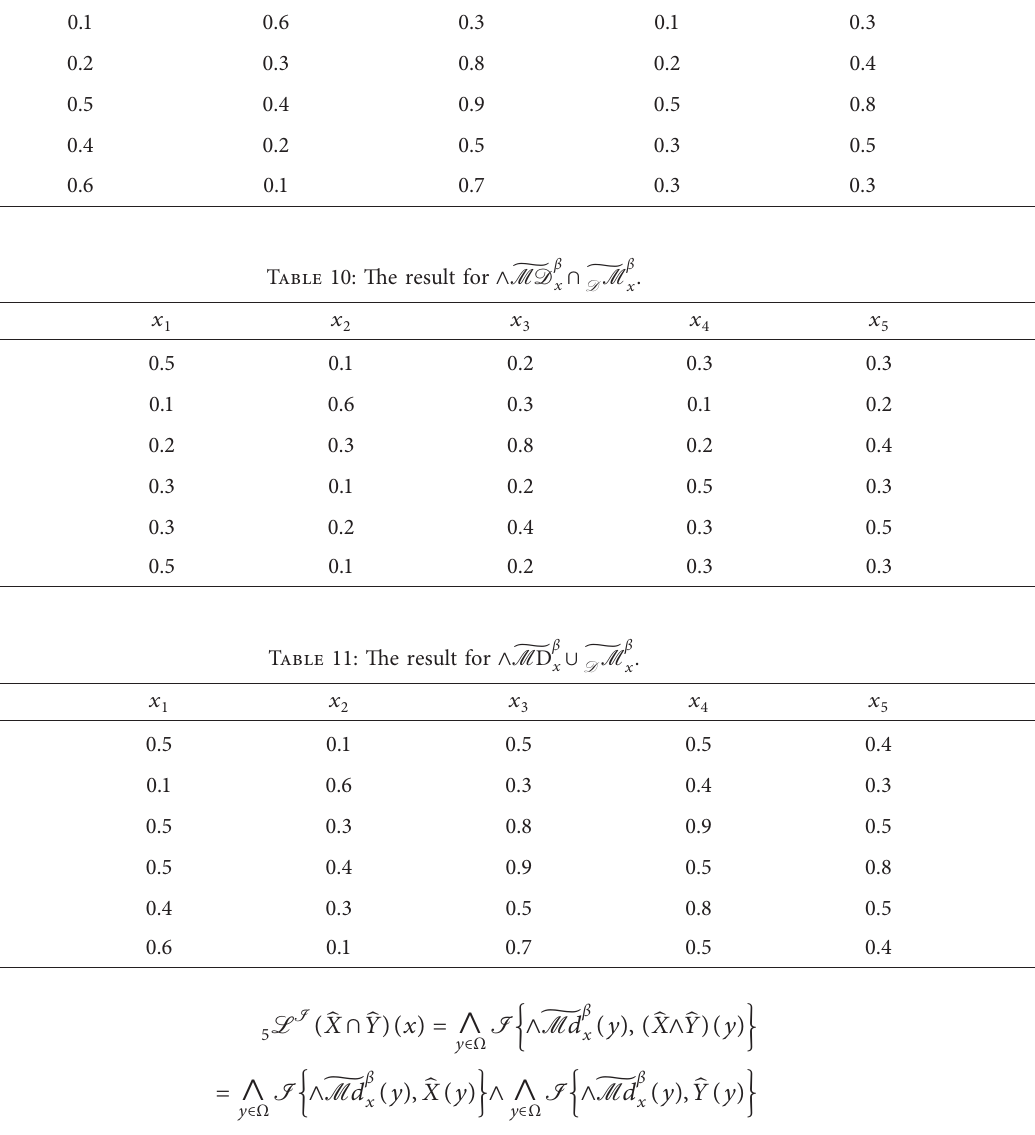
Table 9: Values of 􏽧